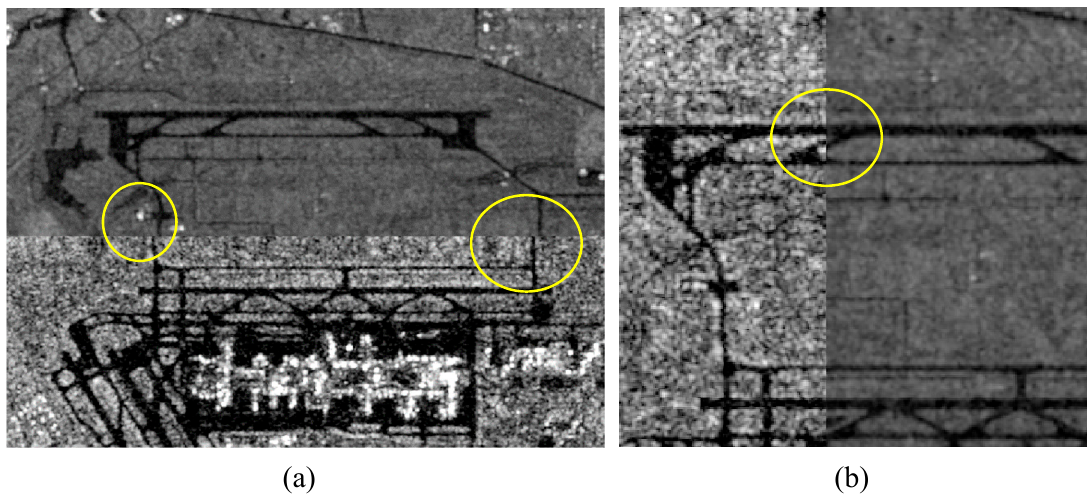
Figure 2. ( a ) Vertical and ( b ) horizontal swipe demonstration of the geometric error (circulated tracks) between two Sentinel-1 SAR images georeferenced by Range-Doppler algorithm in Sentinel Application Platform (SNAP) 6.0 software using the Shuttle Radar Topography Mission (STRM) 3’’ DEM data. The background and foreground images were obtained, respectively, over George Bush International Airport, Texas.